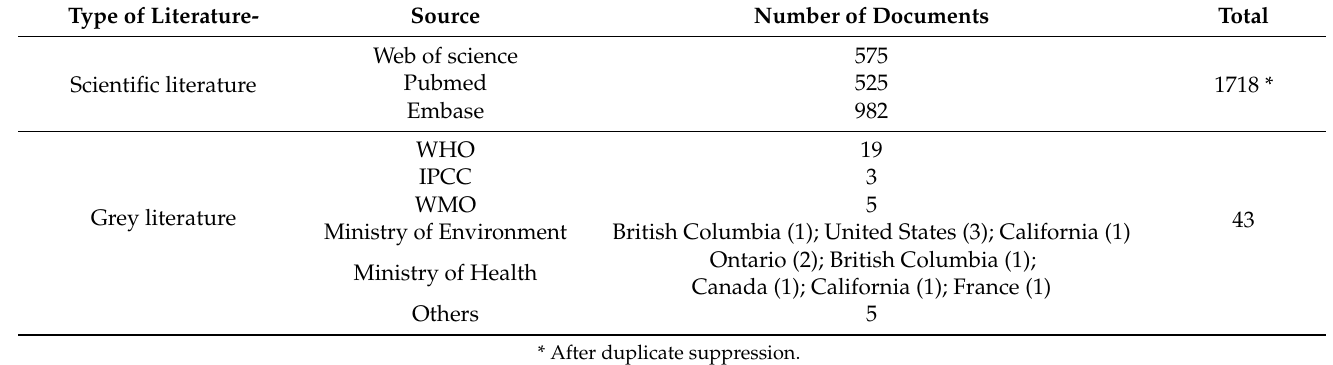
Table 1. Scientific and grey literature review results, number of articles by language and database.